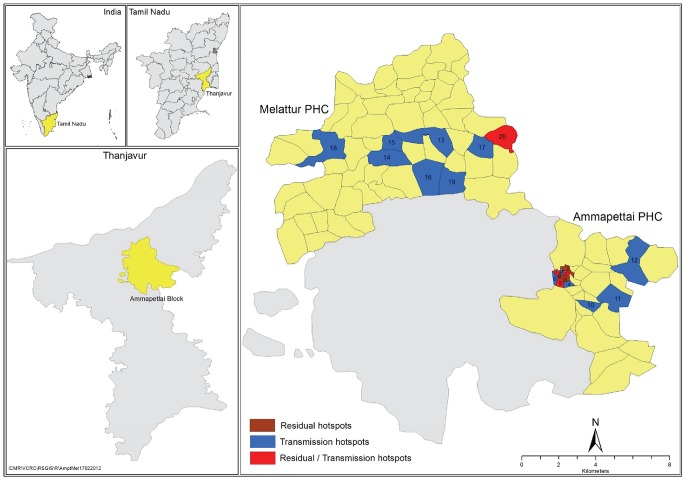
Map showing the study area along with ‘hotspots’.